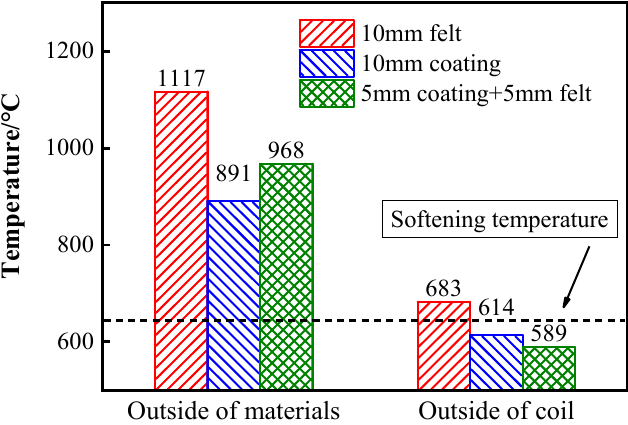
Figure 10. E ff ect comparison of three heat insulation Figure 10. Effect comparison of three heat insulation methods.